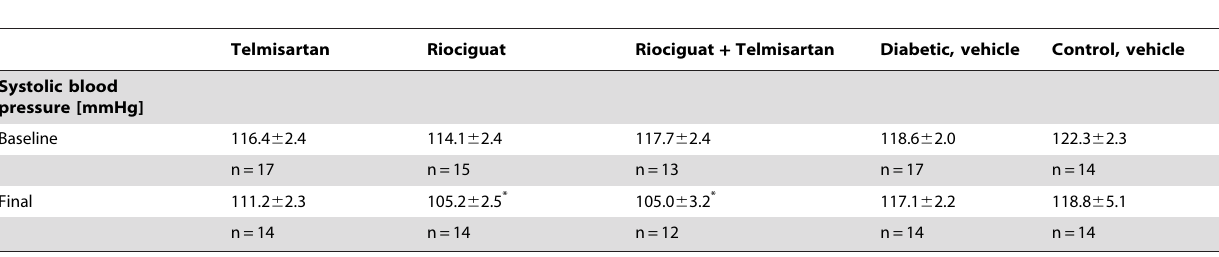
Table 1. Experimental progress of blood pressure and blood glucose in diabetic eNOS knockout mice treated with riociguat (3 mg/kg/d), telmisartan (1 mg/kg/d), both (3 mg/kg/d and 1 mg/kg/d) or vehicle.